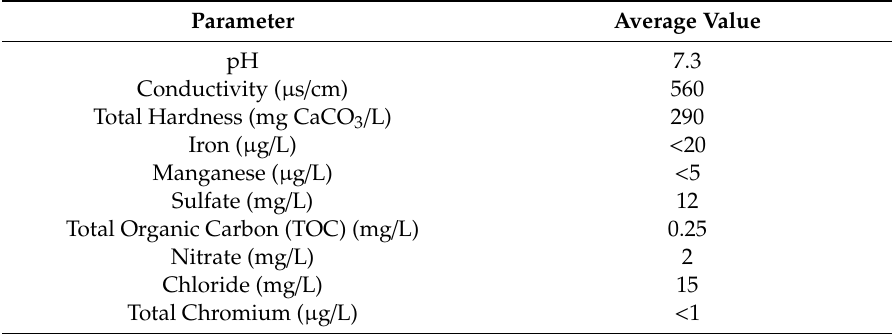
Table 1. Physicochemical parameters of the drinking water from the city of Thessaloniki